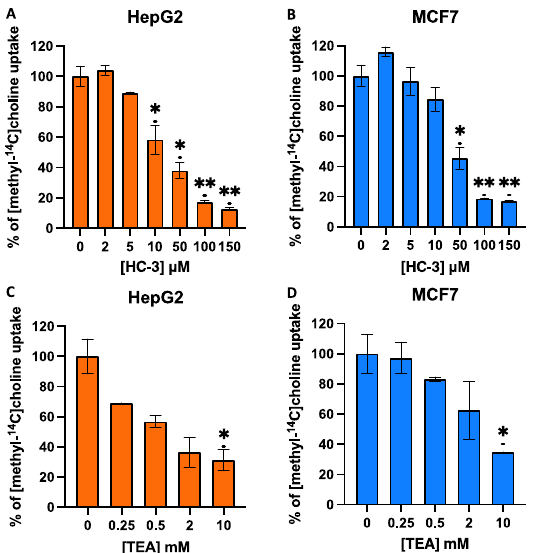
Figure 3. Effects of hemicholinium-3 (HC-3) ( A , B ) or tetraethylammonium (TEA) ( C , D ) on choline uptake in HepG2 and MCF7 cell lines. Choline uptake was assayed in cells treated for 10 min with increasing concentrations of inhibitors dissolved in sodium-free buffer (SFB). Data represent the mean ± SEM of two independent experiments conducted in triplicate. Results are normalised to their respective controls. * p < 0.05, ** p < 0.001.